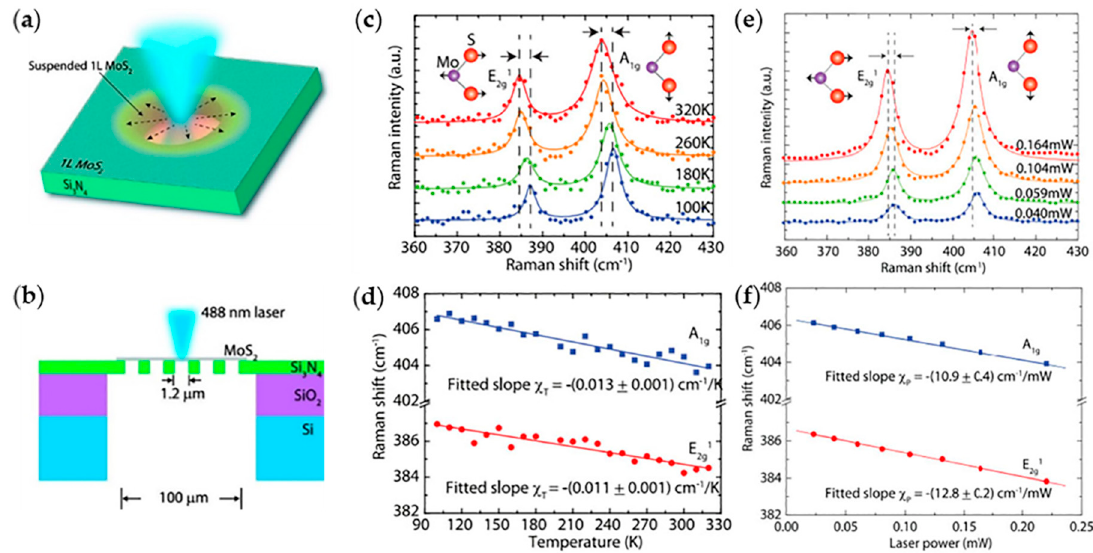
Figure 8. Thermal conductivity measurements of MoS 2 using micro-Raman technique. ( a ) Illustration of the experimental setup for measuring. ( b ) The sectional view of ( a ). Here suspended monolayer MoS 2 over the holes in the 20 nm thick Si 3 N 4 on SiO 2 /Si substrate is presented. ( c ) The Raman spectra of suspended monolayer MoS 2 at 320, 260, 180 and 100 K. The atomic vibrational modes of in-plane E 2g1 and out-of-plane A 1g are inserted in the diagram for clarity. ( d ) Raman peak frequencies of both Raman A 1g and E 2g1 modes as a function of temperature. The fitted slope resulting linear temperature coefficients are shown. The blue line is the A 1g mode and red line is the E 2g1 mode. ( e ) The Raman spectra of suspended monolayer MoS 2 at laser power of 0.164, 0.104, 0.059 and 0.040 mW, respectively. The atomic vibrational modes of A 1g and E 2g1 are inserted in the diagram for clarity. ( f ) Raman peak frequencies of both Raman A 1g and E 2g1 modes as a function of temperature. The fitted slope resulting linear power coefficients are shown. Reproduced with permission from [110]. Copyright 2014, American Chemical Society. Table 1. Comparison of the thermal conductivity measurement parameters of different layered samples by Raman spectroscopy at room temperature.